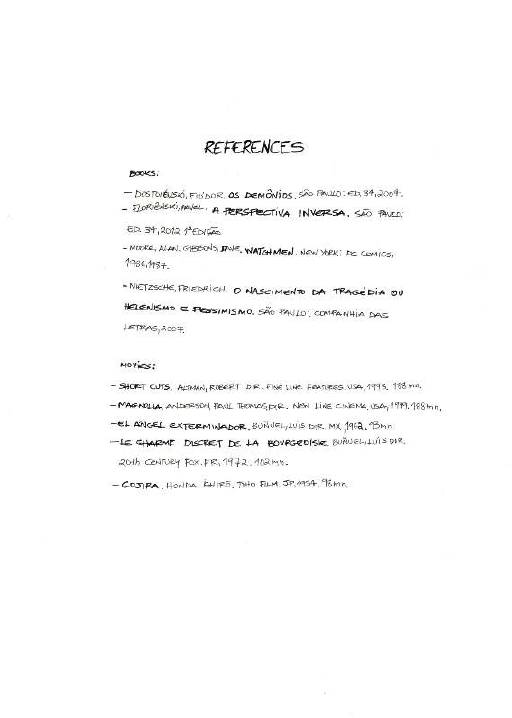
Figure 18: References, Diamond Princess